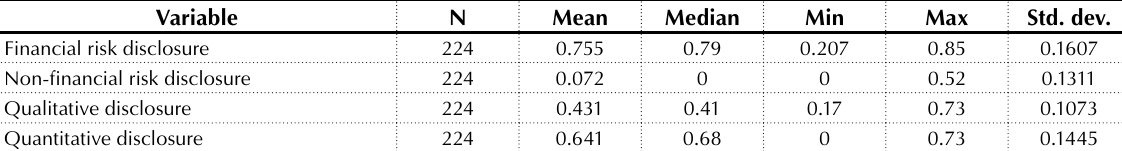
Table 4. Descriptive analysis of the characteristics of risk disclosure in Egyptian